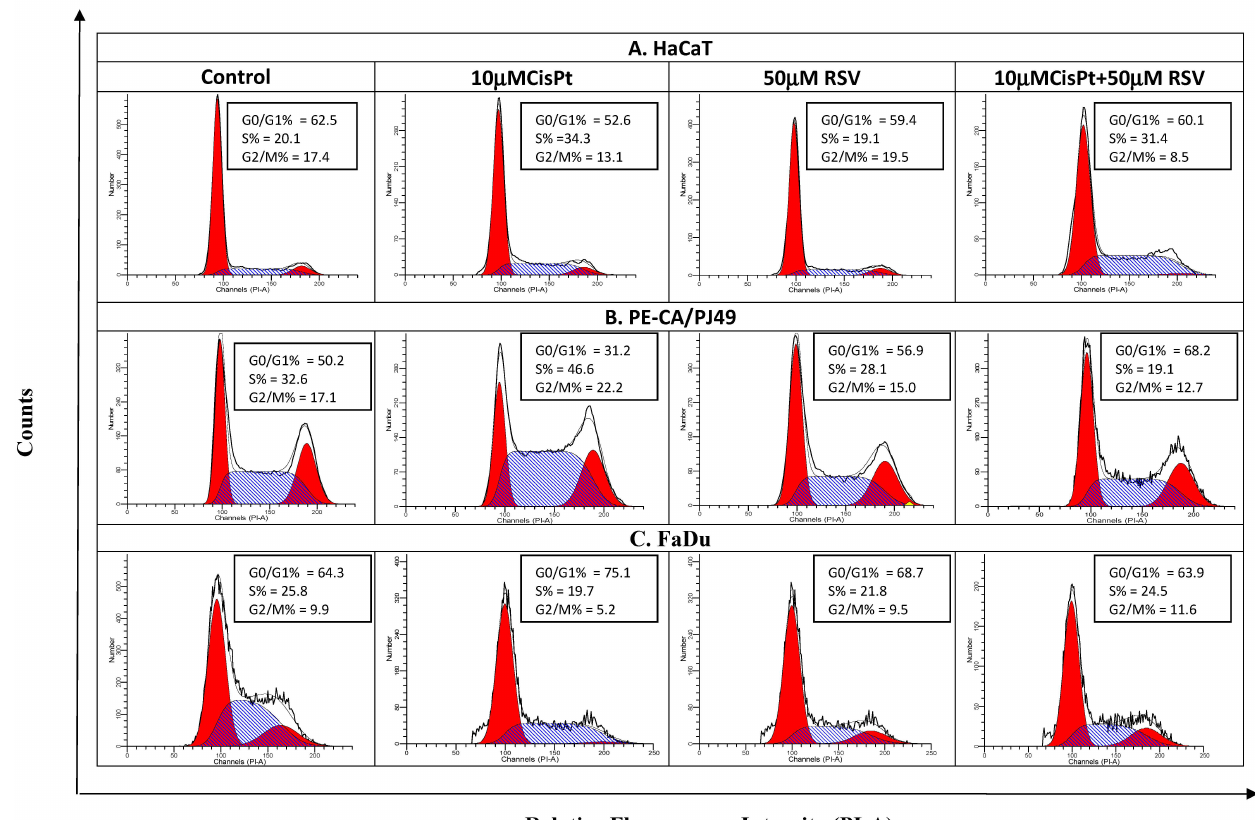
Figure 5. The effect of the treatment with CisPt and/or RSV on cell cycle phase distribution in normal cells HaCaT ( A ), PE/CA-PJ49 ( B ), and FaDu tumor cells ( C ) flow cytometry histograms. Figure 6. original